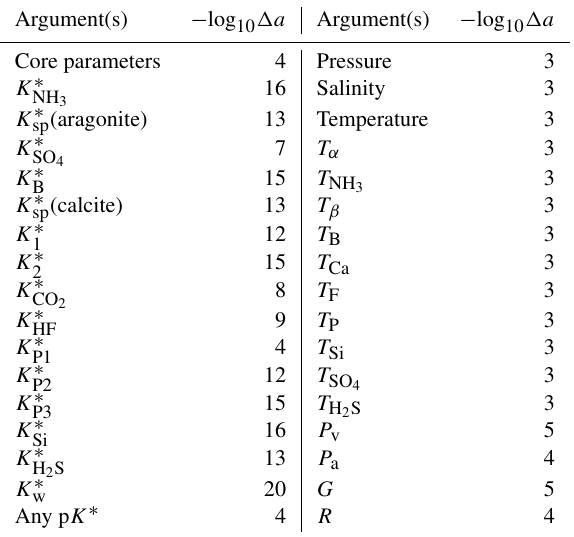
Table H1. Fixed (cid:49)a values for uncertainty